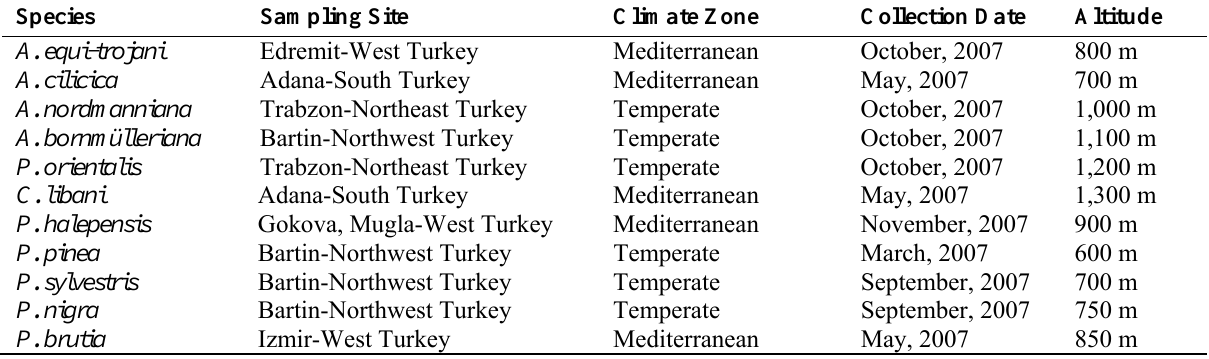
Table 4. Names, collection place, climate zone, date and altitude of the analysed tree